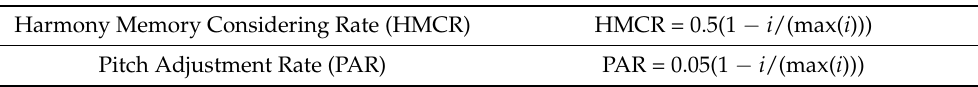
Table A1. HS Algorithm Parameters. Harmony Memory Considering Rate